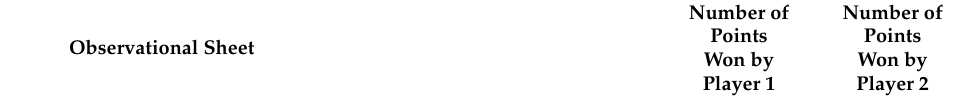
Table 1. Observational